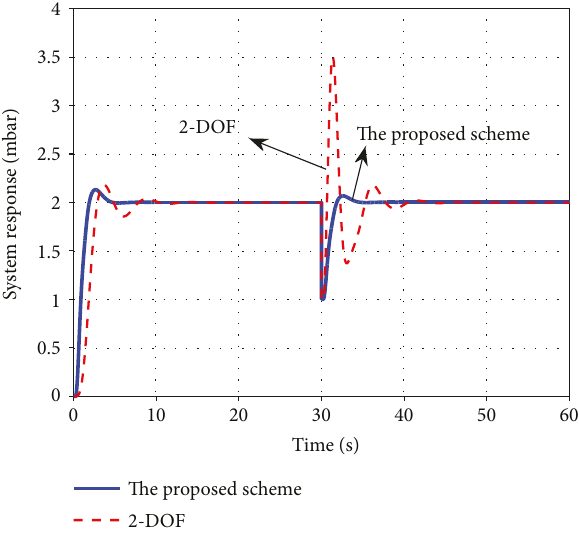
Figure 11: System response comparison with step disturbance.